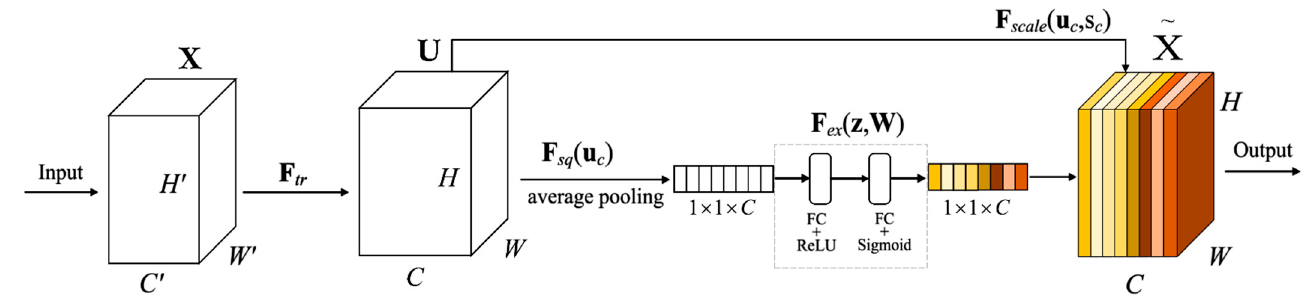
Figure 4. An illustration of the Squeeze-and-Excitation